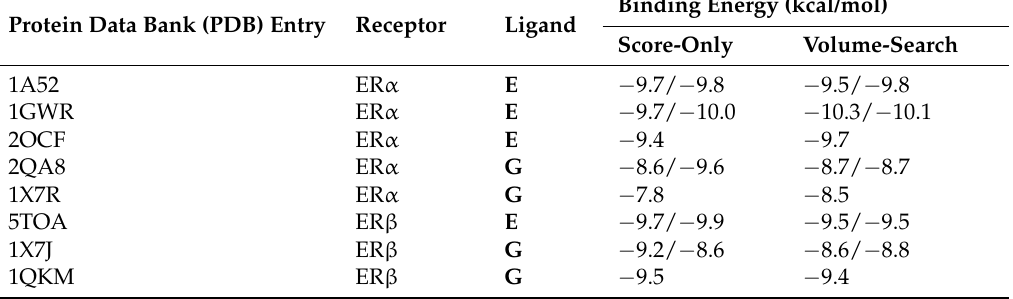
Table 2. Binding energies for E and G complexed with ER α and ER β . Energetic evaluation is performed by using the scoring function of AutoDock Vina [47], either without any search (score-only assessment for the crystallographic poses of the ligands) or exploring the whole receptor (volume-search on the protein structure) followed by a minimization refinement for the complex obtained. Results for receptors in dimeric form are reported with two values corresponding to chain A and B,